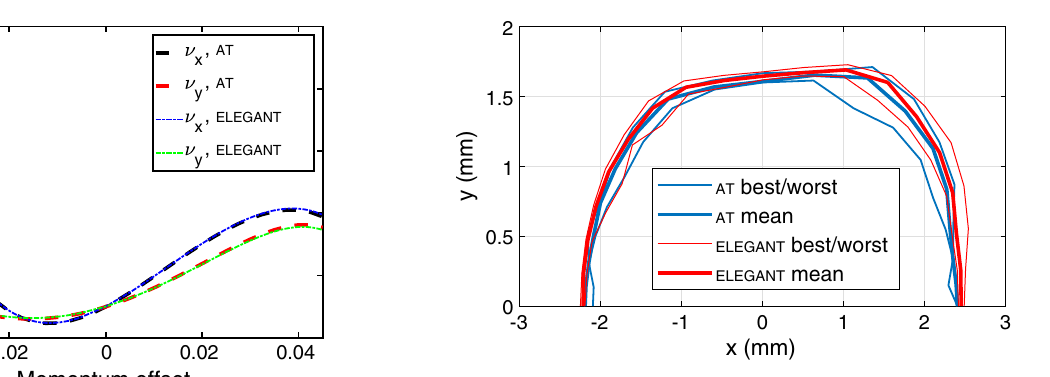
FIG. 11. Dynamic apertures with the same 25 error seeds evaluated by AT and ELEGANT are compared. The thin curves show the average DA of the 25 seeds, while the thin curves show the best and worst of all seeds. Tracking is done with physical apertures and radiation effects by bends. Rf voltage is at 4.8 MV.